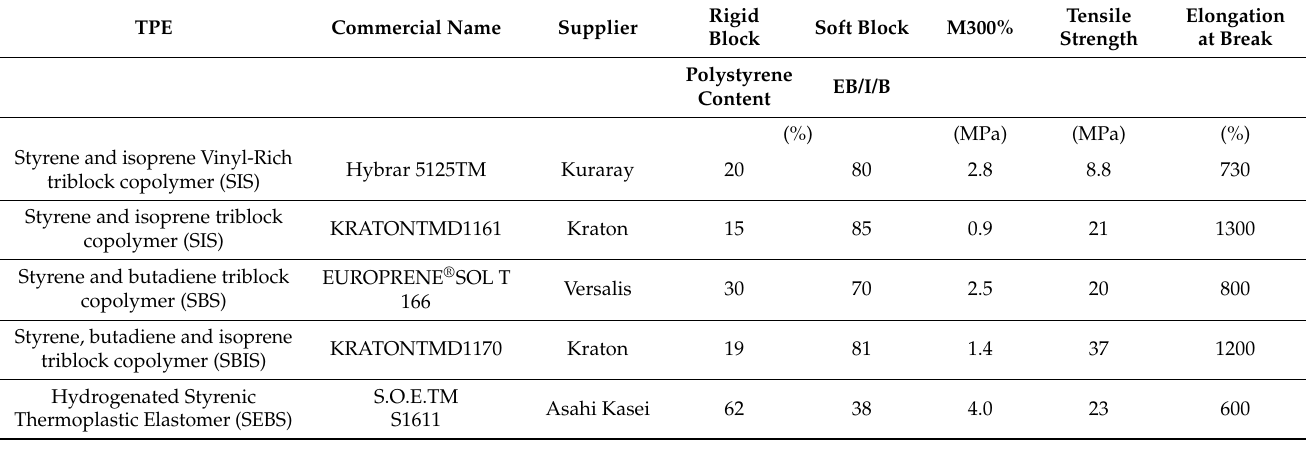
Table 3. Properties of the commercial TPEs for tyre tread formulation, as reported in the technical data sheets by the suppliers. TPE